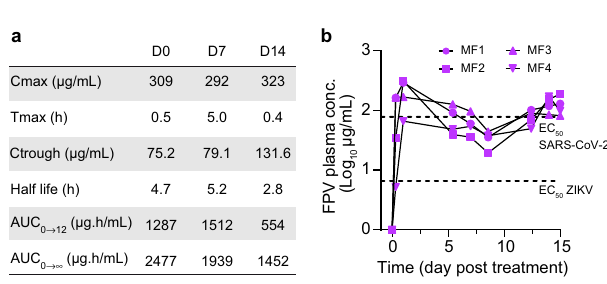
Fig. 2 | Plasma FPV concentration of four uninfected NHPs. a Favipiravir phar- macokinetic parameters during treatment with 250mg/kg BID i.v. on day 0 fol- lowed by 150mg/kg BID s.c. for 14 days. b Longitudinal evolution of plasma FPV concentrationswithrespecttoEC 50 valuesobtainedonZIKVandSARS-CoV-2given in refs. 7, 12. Source data are provided as a Source Data fi